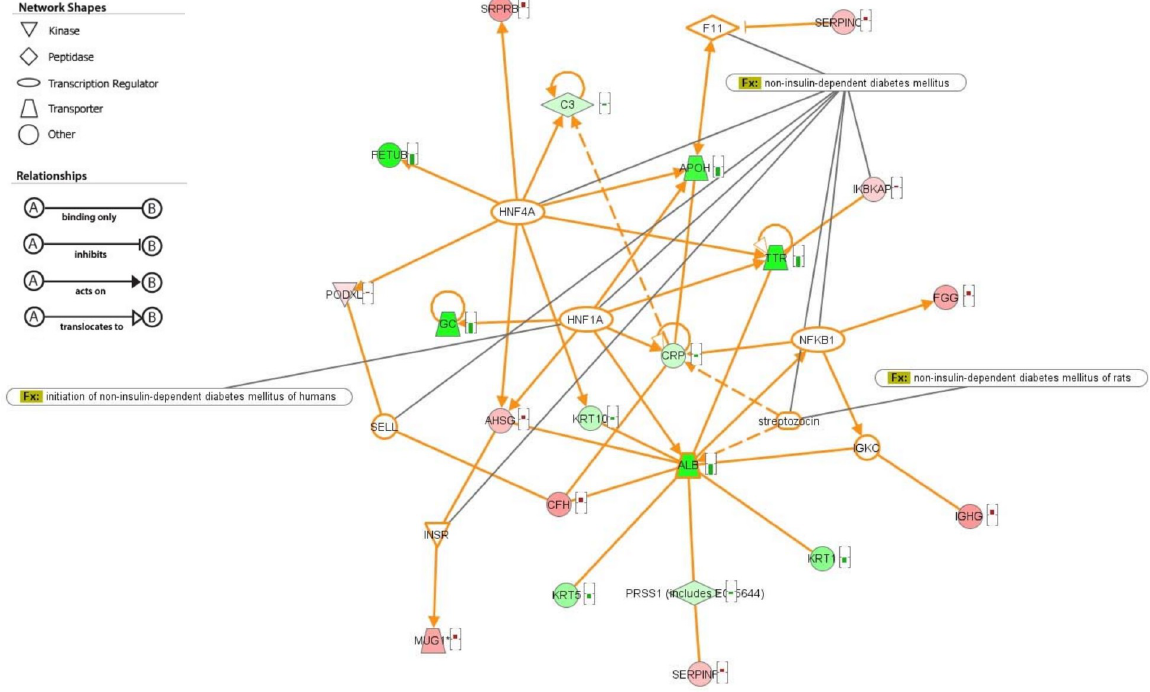
Fig 6. Association between differentially expressed proteins and pathways related to non-insulin dependent diabetes. Associated pathways of 24 proteins were linked with additional 7 proteins selected from IPA database with the association of non-insulin dependent diabetes. Green color labels indicate the increment of serum protein in diabetic condition. Red color labels indicates the reduction of serum protein in diabetic condition. Locations of proteins and associations of proteins were shown by indicated drawings.